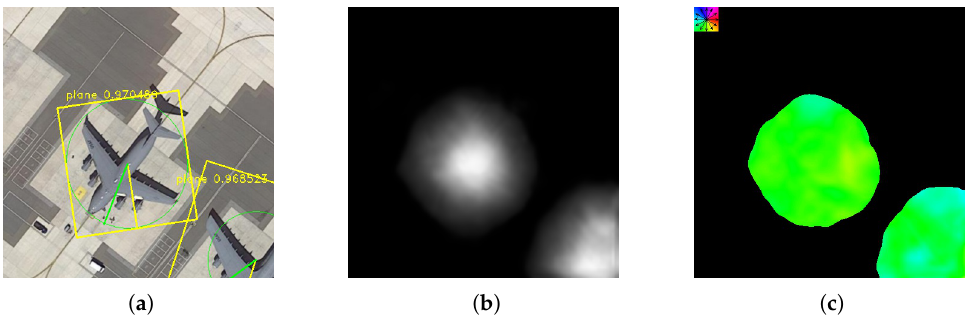
Figure 1. The presentation of object field. ( a ) is original image, ( b ) is Center Field and ( c ) is Direction Field. We can fit the object by ( b ). Also, we can get the direction through ( c